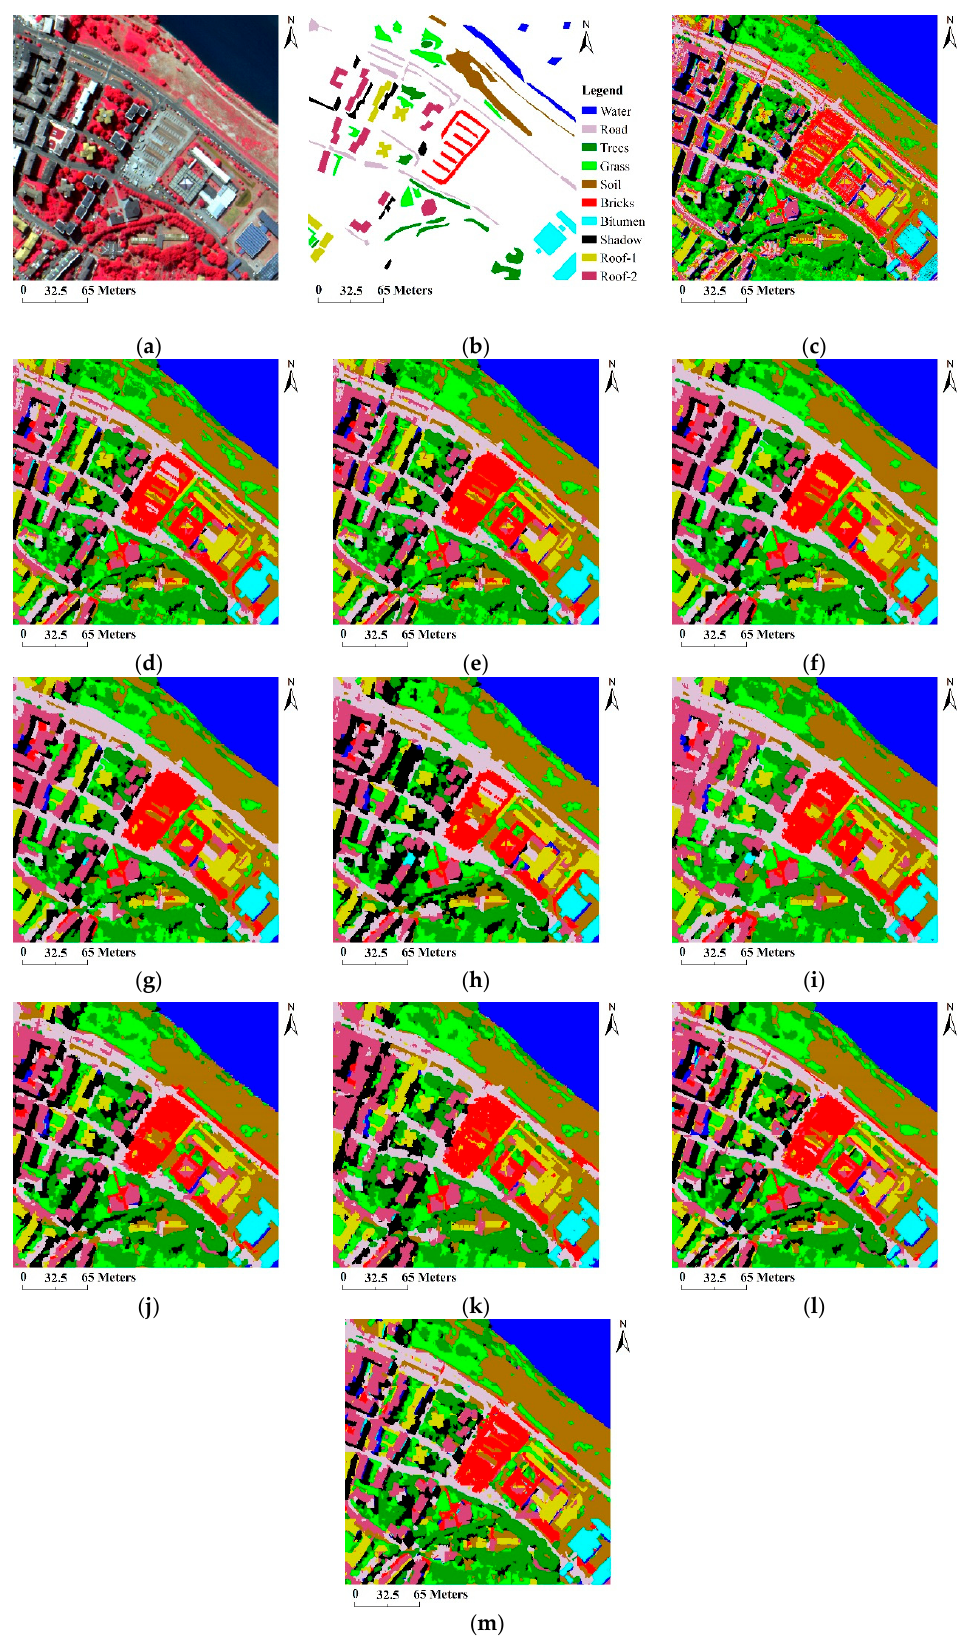
Figure 11. Classification maps for the Centre of Pavia data set: ( a ) CIR colour composite (bands 63, 52, and 36); ( b ) Ground truth data; ( c ) SVM; ( d ) Proba-M-HSEG; ( e ) Proba-M-HSEG +MV; ( f ) Morph-M-HSEG; ( g ) Morph-M-HSEG +MV; ( h ) Proba-M-MSF using ED; ( i ) Proba-M-MSF using SAM; ( j ) Proba-M-MSF +MV using ED; ( k ) Proba-M-MSF +MV using SAM; ( l ) AMG-M-HSEG using ED; and ( m ) AMG-M-HSEG using SAM.